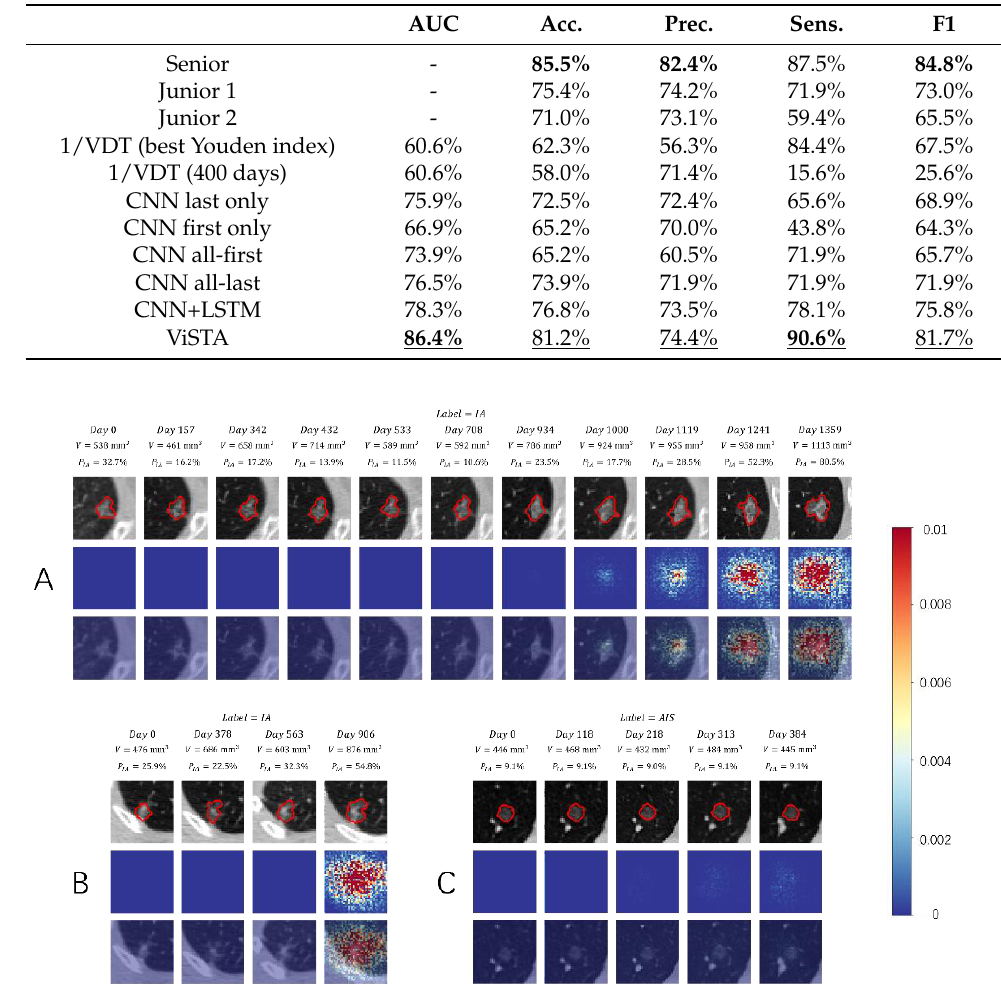
Figure 3. Visualization investigation of ViSTA. The top row shows CT slices of each time point in the follow-up series. The middle row shows attention heatmaps extracted using the technique proposed by Simonyan, K. et al. [26]. The bottom row masks heatmaps on top of CT slices. ( A ) Attention gradually grew along with the nodule volume and IA probability as the nodule progressed to the end of the series. ( B ) The heatmap only lit up at the last time point as it is considered the one carrying valuable information. ( C ) All time points are allocated with little to no attention, which may be caused by the slow progress of the nodule.